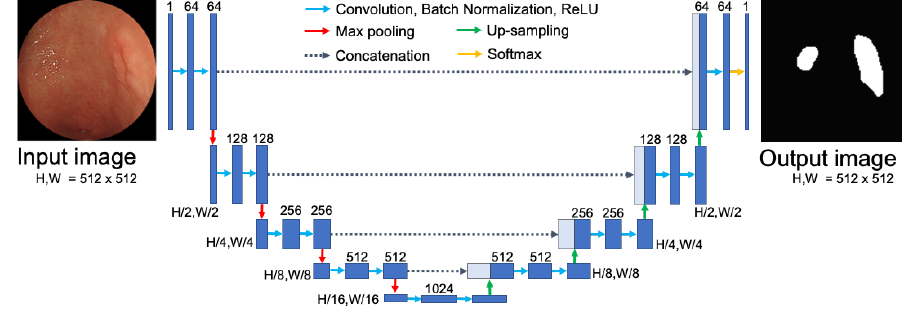
Figure 2. Architecture of U-Net.